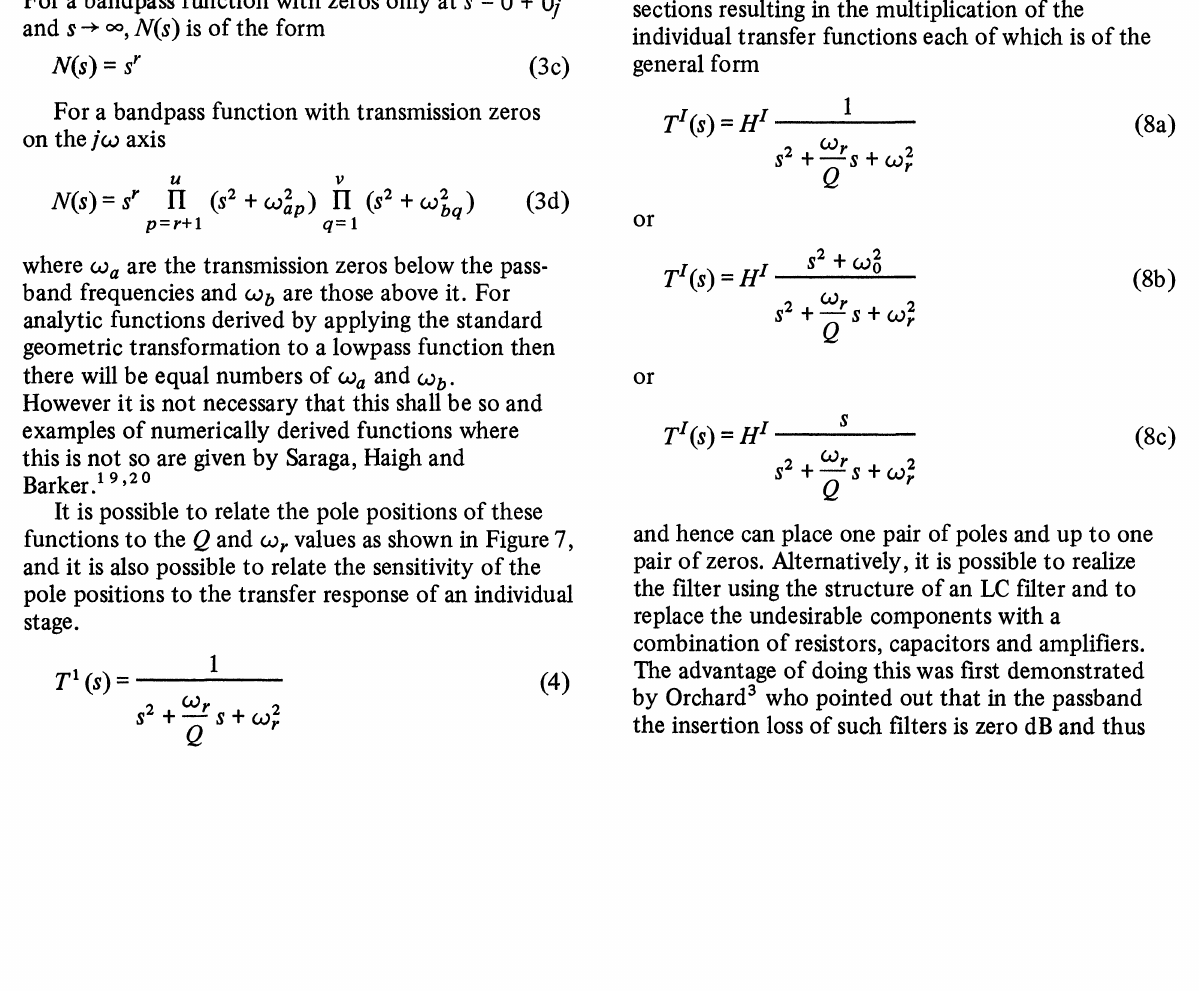
r from the pole